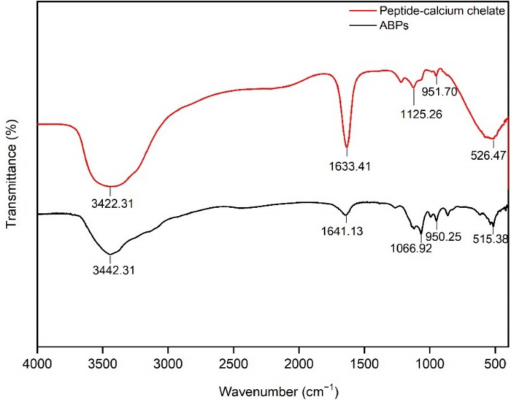
Figure 2. FTIR measurement of BPs and peptide–calcium chelate. ABPs (black line): antler bone peptides, peptide–calcium chelate (red line): antler bone peptide–calcium